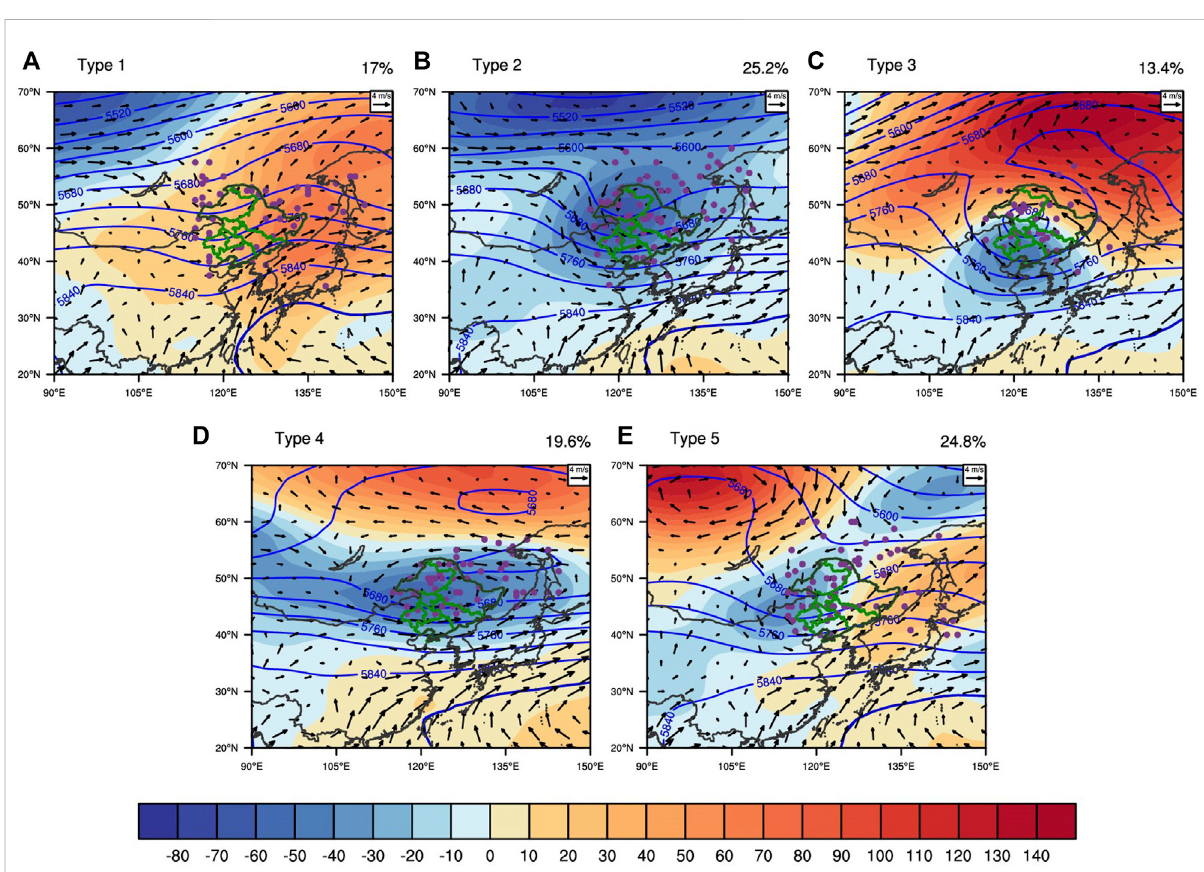
FIGURE 4 Geopotential height (solid blue lines, units: gpm), geopotential height anomaly (shaded, units: gpm) at 500 hPa, and wind at 850 hPa (arrow, units: m/s) under fi ve types of synoptic circulation patterns (A-E) obtained by SOM. The percentages for each circulation type are shown on the top right. Composite fi elds for the rainstrom days associated with NECVs of each type are shown in FIGUREs (similarly to Figures 8, 9). The purple dots represent the daily mean locations of the NECVs, and the green map denotes the